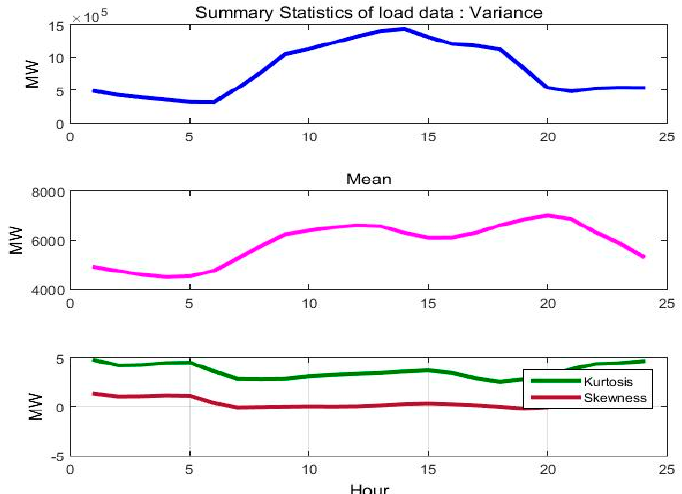
Figure 4. Profile of variance, meankurtosis and Skewness of load, for hours 1 to 24, for the period 2004–2014. The variation of load with average daily temperature is depicted in Figure 5.